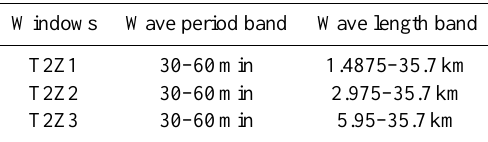
Table 2. Same as Table 1 except that the window was used for Stokes parameters analysis.